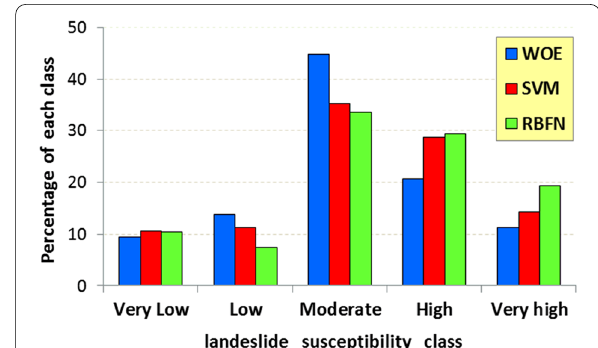
Fig. 9 Distribution of landslides in each landslide susceptibility category